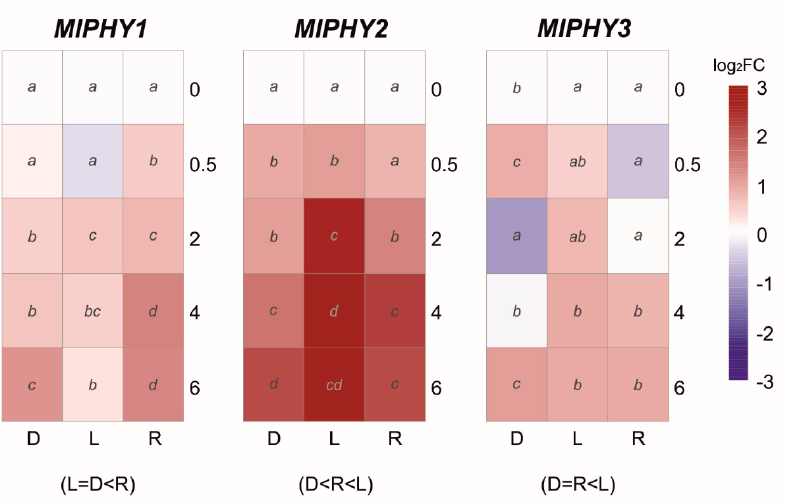
Figure 6. The heat maps represent changes in the relative gene expression of two opsins ( OPS ) coding genes under continuous darkness (D), daylight (L), or green (G) light at different time points. The scale is log 2 of fold change mean values after normalization against 0 h post illumina- tion using the 2 −ΔΔ CT method. Red color represents a higher relative expression than 0 h post illu- mination, and blue color represents a lower relative expression. Data were analyzed between light sources containing all times (shown at the bottom between brackets), and by light source between times (letters) by analysis of variance; the mean values with the same letter are not significantly different p ≤ 0.05) according to Duncan’s multiple range test.